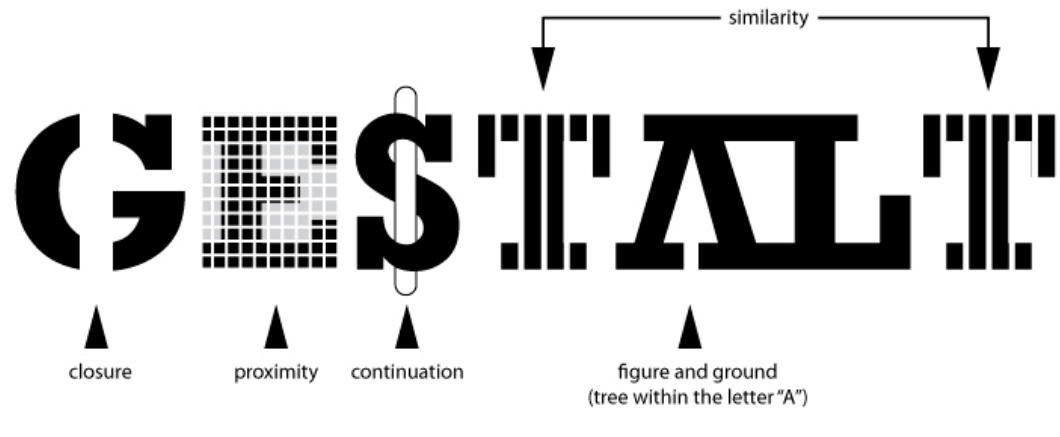
Figure 1. GESTALT’s